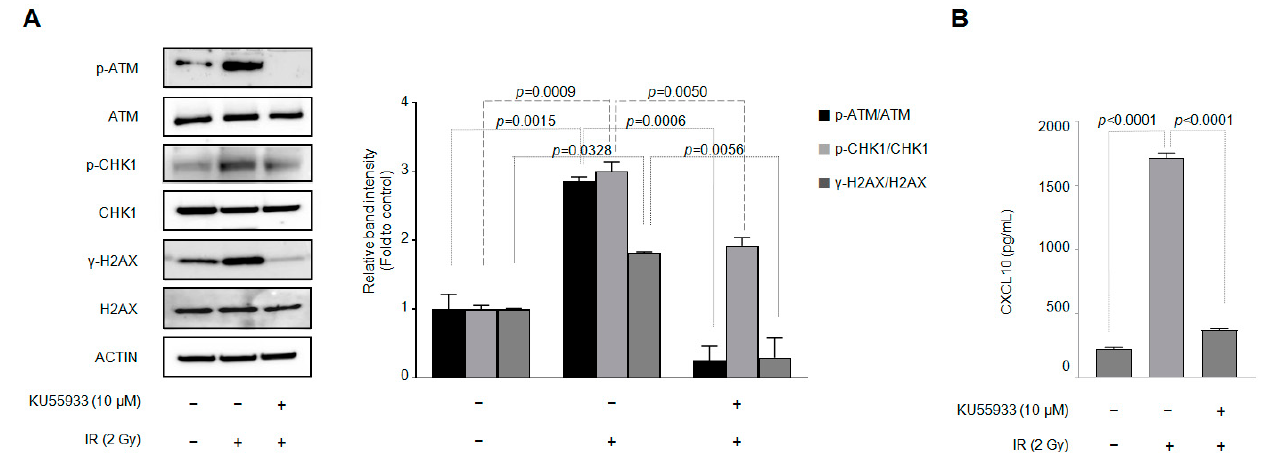
Figure 2. DNA damage by ionizing radiation is involved in the production of CXCL10 in J774A.1 macrophages. A total of 2 × 10 5 cells/mL of the J774A.1 macrophage cell line, with or without the